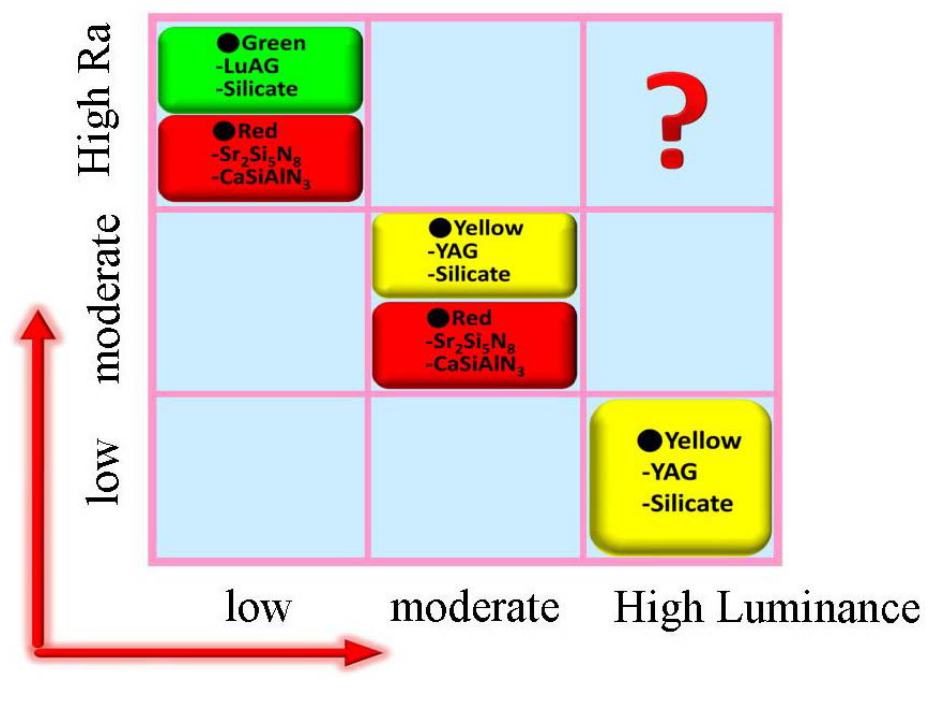
Figure 29. Strategies for white light generating by combining blue light-emitting diodes with different converting